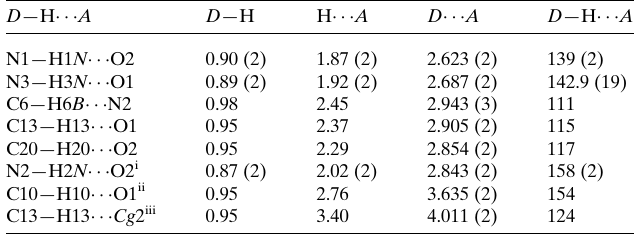
Table 4 Hydrogen-bond geometry (A˚ , (cid:3) ) for ( I ).